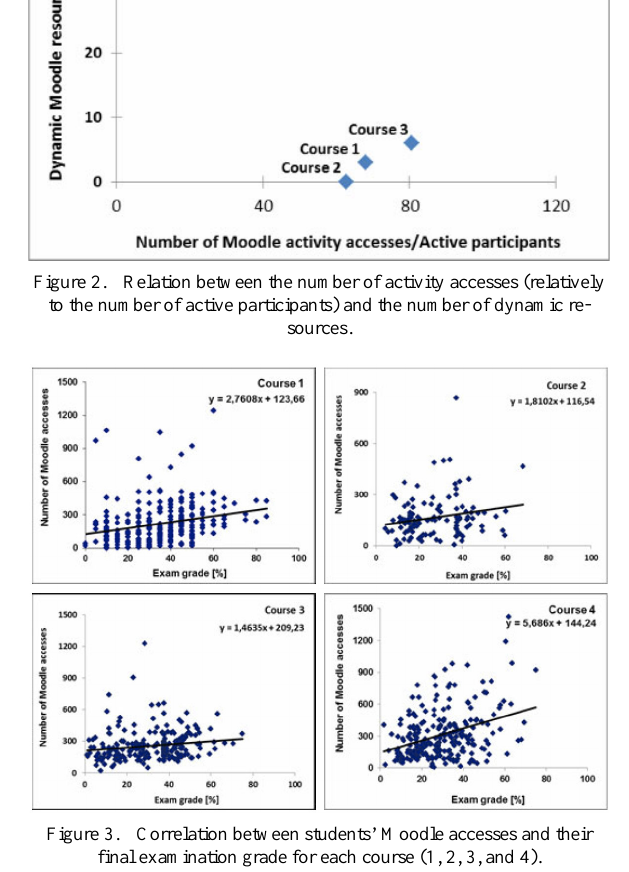
TABLE VII. P EARSONS ’ ANALYSIS BETWEEN MOODLE ACESSES AND STUDENTS ’ GRADES Correlations of students’ number